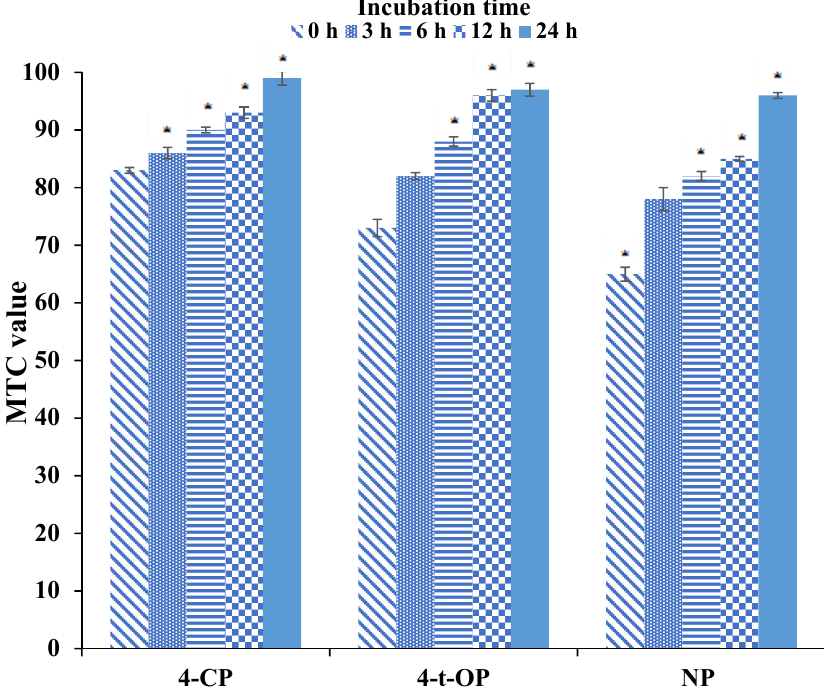
Figure 1. Mean MTC values in the MARA test with 4-CP, NP, and 4- t -OP fungal culture exposure. An asterisk (*) indicates statistically significant differences from the control ( p ≤ 0.05).